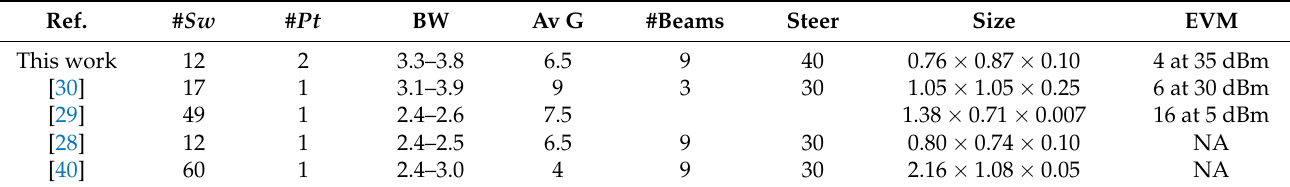
Table 3. Comparison between the designed antenna and other antennas reported on literature. (# Sw : Number of switches, # Pt : Number of ports, BW: Bandwidth (GHz), Av. G: Average Gain (dB), # Beams: Number of beams, Steer: Beam steering angle (deg), Size: Occupied volume (wavelengths at central frequency), EVM: Mean EVM (%) at a given input power.